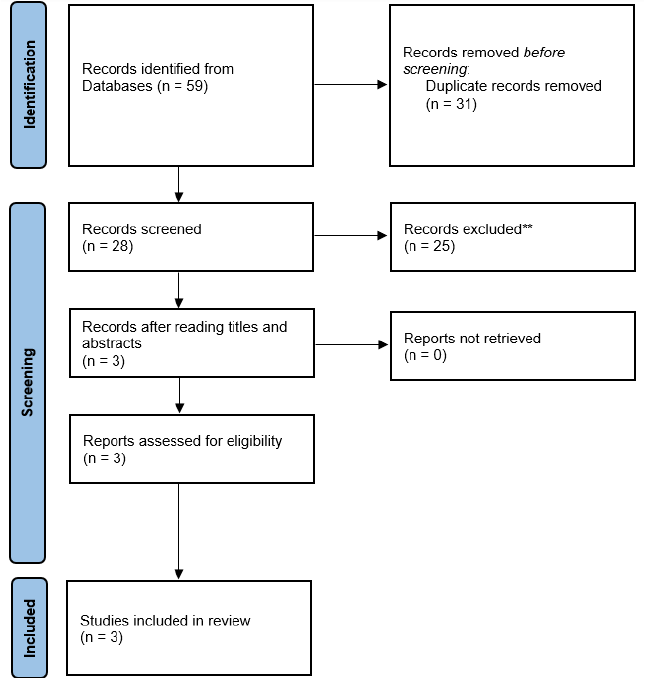
Figure 4. Flow diagram of the selected studies. (** Excluded records after peer review).